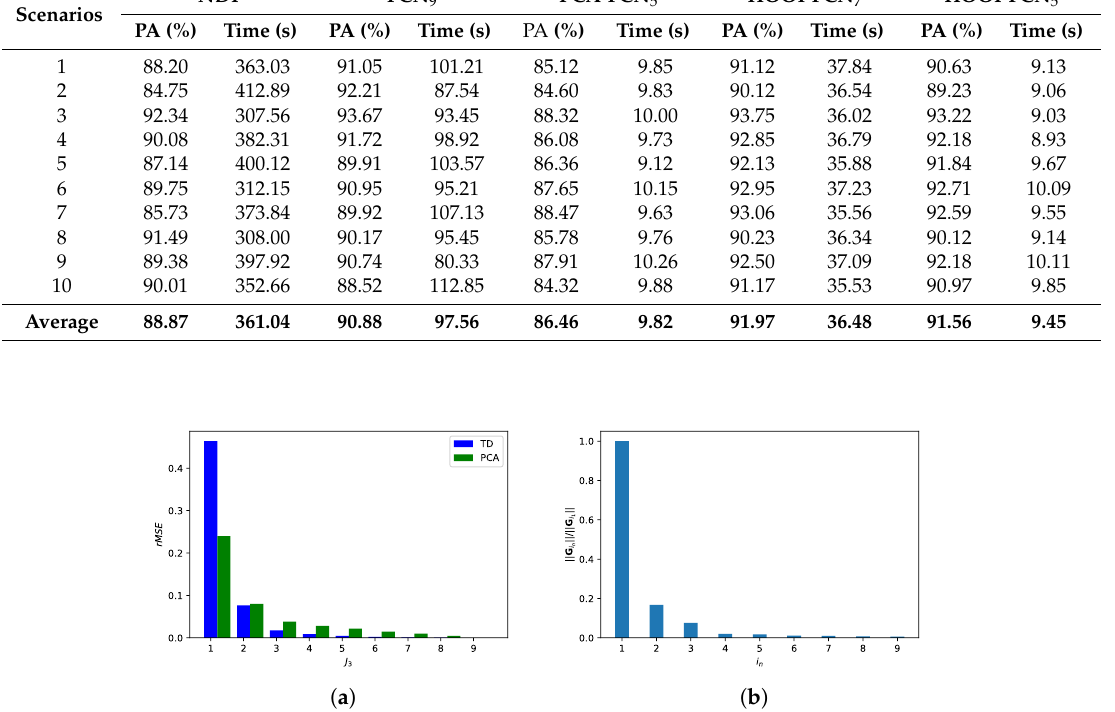
Figure 6. TD metrics ( a ) Reconstruction error computed by the relative mean square error (rMSE) for J 3 = 1,..., I 3 and ( b ) norm of each subtensor GGG i